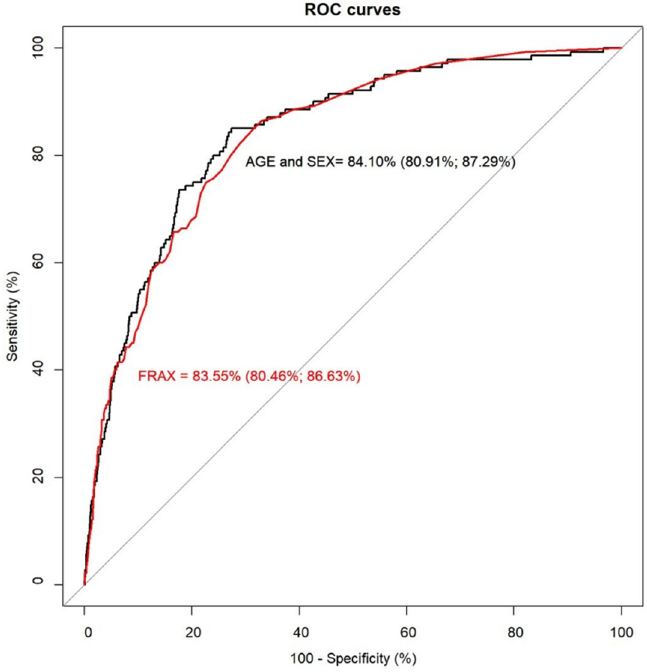
Figure 2. Receiver operating characteristic curves for FRAX and the age and sex model.